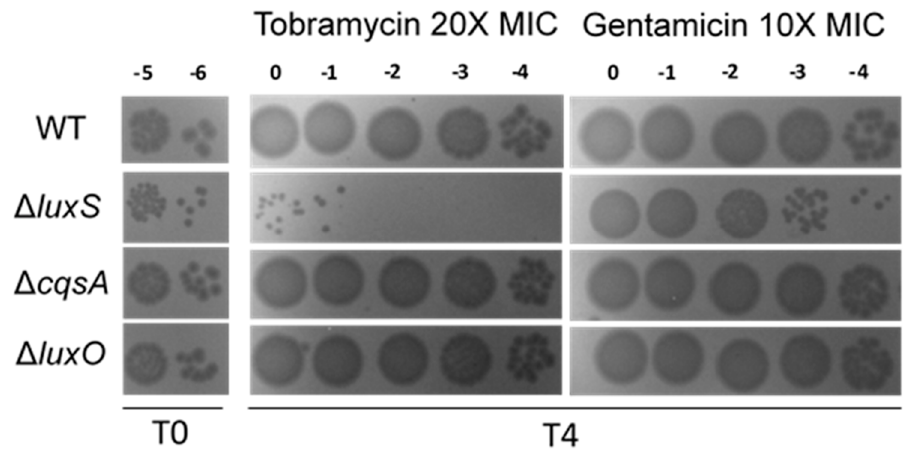
Table 2. MIC measured by E-test (µg/mL).